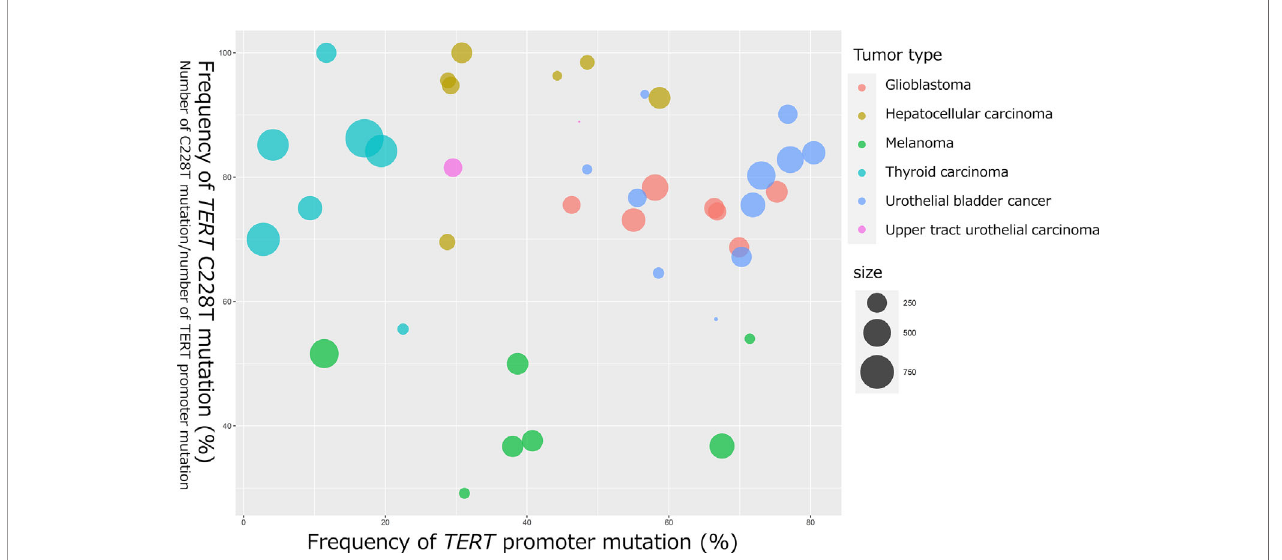
FIGURE 1 | Bubble chart indicating the frequency of TERT promoter mutation and TERT C228T mutation in glioblastoma, HCC, melanoma, papillary thyroid cancer, UBC, and UTUC. The horizontal axis represents the frequency of TERT promoter mutations (number of TERT promoter mutations per number of all cases). The vertical axis represents the frequency of TERT C228T mutation (number of TERT C228T mutations per number of TERT promoter mutations). The bubble size represents the number of samples